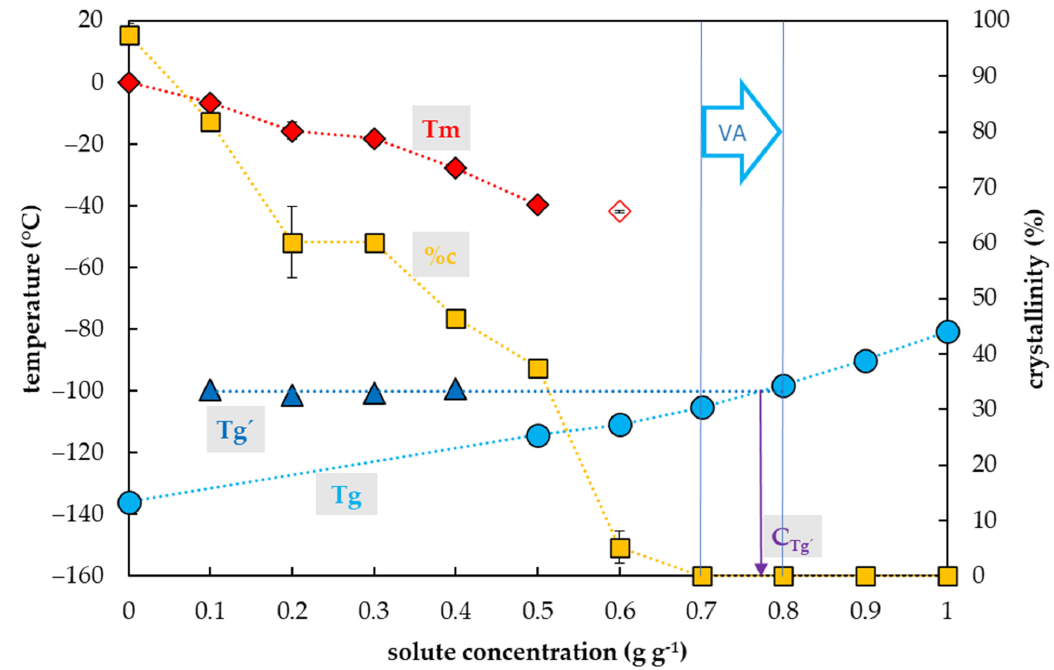
Figure 5. Thermal characteristics of glycerol (Gly) depending on its concentration in an aqueous solution. The total concentration of solutes is expressed as the mass of solutes (g) per mass of aqueous solution (g). The left y -axis indicates the temperature of thermal events and right y -axis shows the percentage of water crystallinity based on the total mass of solution. The temperature of the glass transition (Tg) of the solution is indicated by a cyan circle, the Tg’ originating from the freeze-concentrated solution during the cooling period is indicated by a blue triangle, onset of the water melting peaks (Tm) is indicated by a red diamond if the effect occurs during the cooling period, the onset of the water melting peak is indicated by a hollow diamond if the effect occurs during the warming period. The percentage of crystallinity of the solute (%c) based on the total mass of the solution is indicated by an orange rectangle. The vitrification ability (VA) demonstrates the range of solute concentrations with the appropriate vitrification ability. Cg´ indicates a concentration of the freeze-concentrated solution. All effects were measured during the warming period of the C/W cycles at a rate of 10 °C min − 1 . Results are presented as a mean of three repetitions and vertical bars represent standard error.